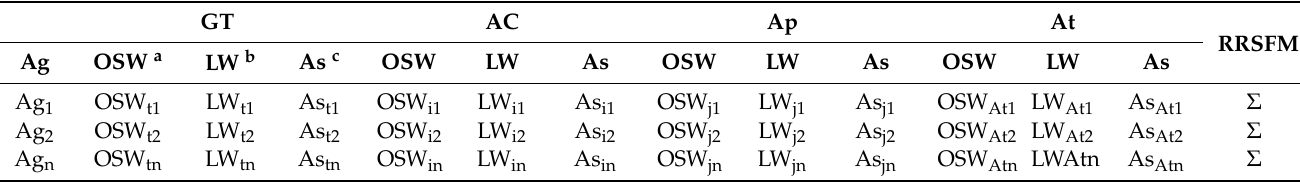
Table 2. Matrix for the analysis of the RRSFM quantitative